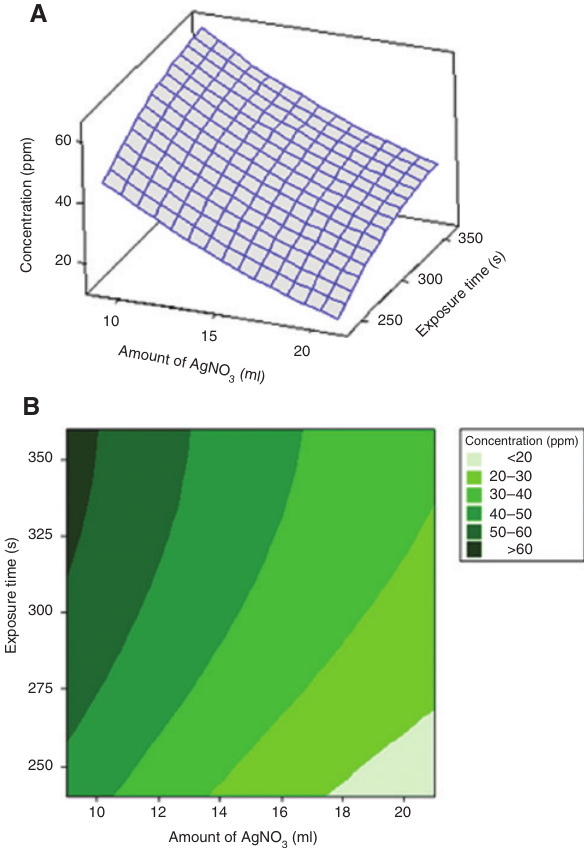
Figure 2: Surface plot (A) and contour plot (B) for AgNPs concentra- tion of produced NPs solution as a function of significant (p < 0.05) interaction effects of microwave exposure time and amount of AgNO 3